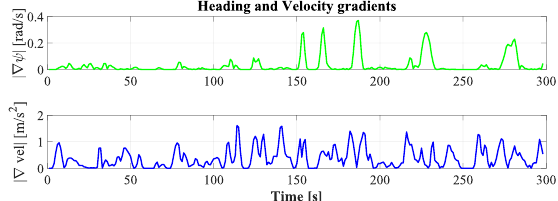
Figure 5. Heading and velocity gradient. Top panel: Change in heading (turns) |∇ ψ | , bottom panel: Changes in the horizontal velocity |∇ vel NE